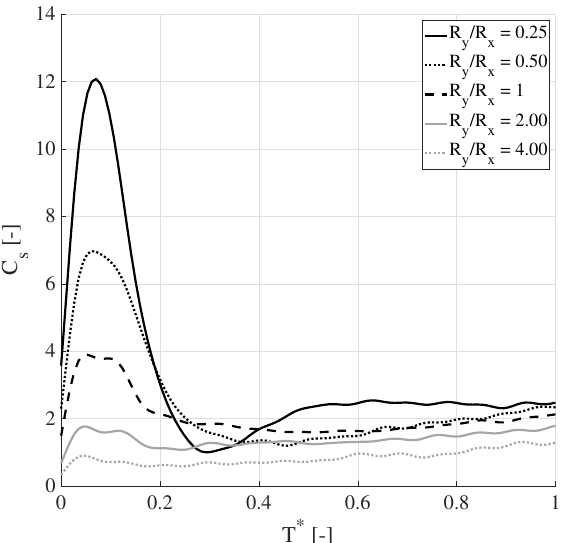
Figure 18. Magnification up to t (cid:63) = 1 of the slamming coefficient as a function of the ellipse aspect ratio. Solid black line represents aspect ratio of 0.25, dotted black line 0.5, dashed black line the circular obstacle with R y / R x = 1.0, solid light gray line the aspect ratio of 2.0, and dotted light gray line the largest aspect ratio of 4.0.